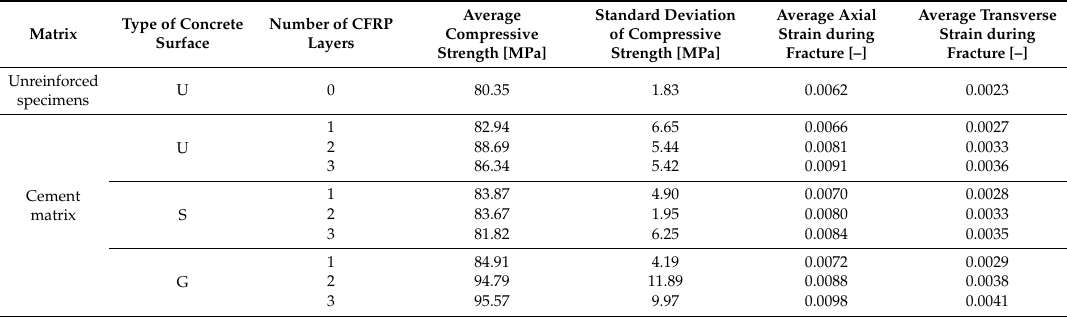
Table 3. Average values of the obtained results for the high-performance, self-compacting, fiber-reinforced concrete (HPSCFRC) and samples reinforced with cement